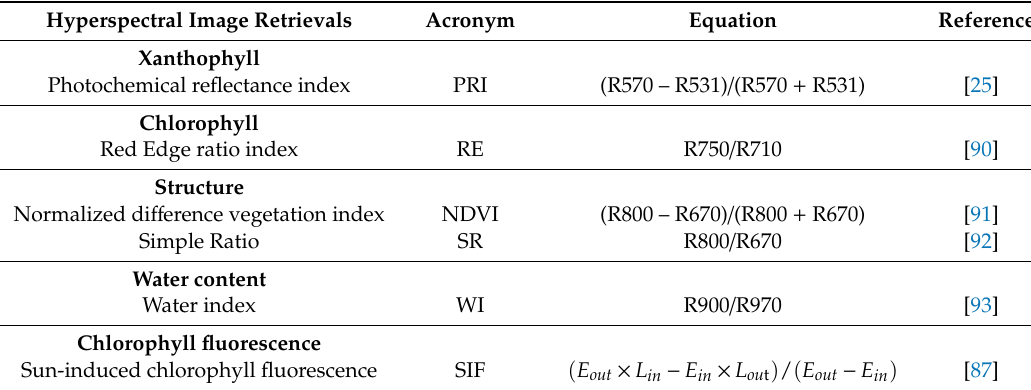
Table 2. Hyperspectral image retrievals used in this